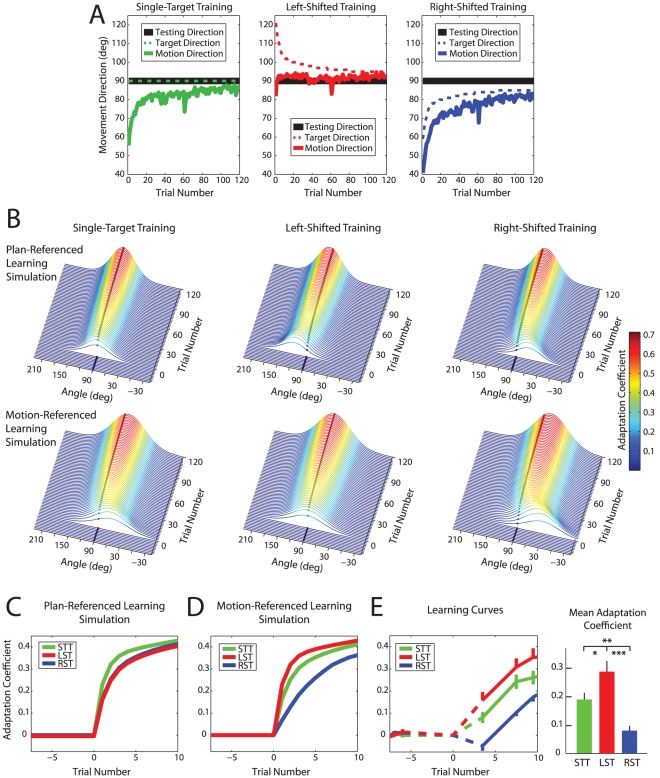
A novel training paradigm improves learning rates.(a) Characterization of the STT, LST and RST training paradigms. Target directions (dashed) and actual movement directions (solid) during the training period are plotted against trial number. Note that the LST paradigm achieves actual movement directions that are much more closely aligned with 90° than the other two paradigms. (b) Simulations of motor adaptation based on the PRL and MRL hypotheses for the three training paradigms. The darkened dots at 90° indicate the desired learning direction and the coloring indicates the amount of adaptation predicted. Note that PRL predicts optimal alignment with STT while MRL predicts optimal alignment with LST. (c) and (d) Predicted learning at 90° for the PRL and MRL hypotheses. Note that these traces represent slices at 90° through the 3-D plots in panel (b), corresponding to the darkened dots. (e) Experimental results for all three training paradigms. Note that over the first 10 trials, the LST paradigm produces the highest adaptation levels, and RST the lowest, as predicted by MRL. The error bars represent standard errors.